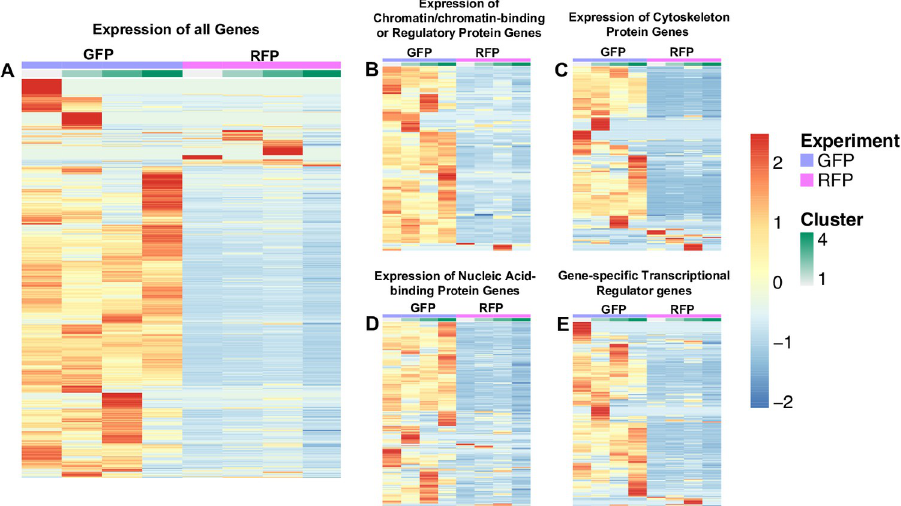
Fig 2. Heat map of differentially expressed genes between GFP+ and RFP+ thrombocytes. Genes were arbitrarily clustered via k-means clustering ranging from k = 2 to k = 10. The expression of genes is based on the average mean counts of cells falling into the generated clusters. The cellRanger t-SNE graphs were used in choosing the best clustering and 4 clusters were found. A spreadsheet with a sheet for each cluster type was generated. The counts covered a large range (0–120+), and row-wise scaling on the values was performed, which provided a range of -2 to 2. A. Expression of all genes, 8746 genes in GFP+ thrombocytes and 6990 genes in RFP+ thrombocytes. B. Expression of chromatin/chromatin-binding or regulatory protein genes, 120 genes in GFP+ thrombocytes and 106 genes in RFP + thrombocytes. C. Expression of cytoskeleton protein genes, 217 genes in GFP+ thrombocytes and 158 genes in RFP + thrombocytes. D. Expression of nucleic acid-binding protein genes, 535 genes in GFP+ thrombocytes, and 478 genes in RFP+ thrombocytes. E. Expression of gene-specific transcriptional regulator genes, 449 genes in GFP + thrombocytes, and 329 genes in RFP+ thrombocytes. Purple indicates GFP+ thrombocytes, and pink indicates RFP + thrombocytes followed by clusters from 1 to 4 shown in light green to dark green. For each gene, red is upregulated, and blue is downregulated in the corresponding